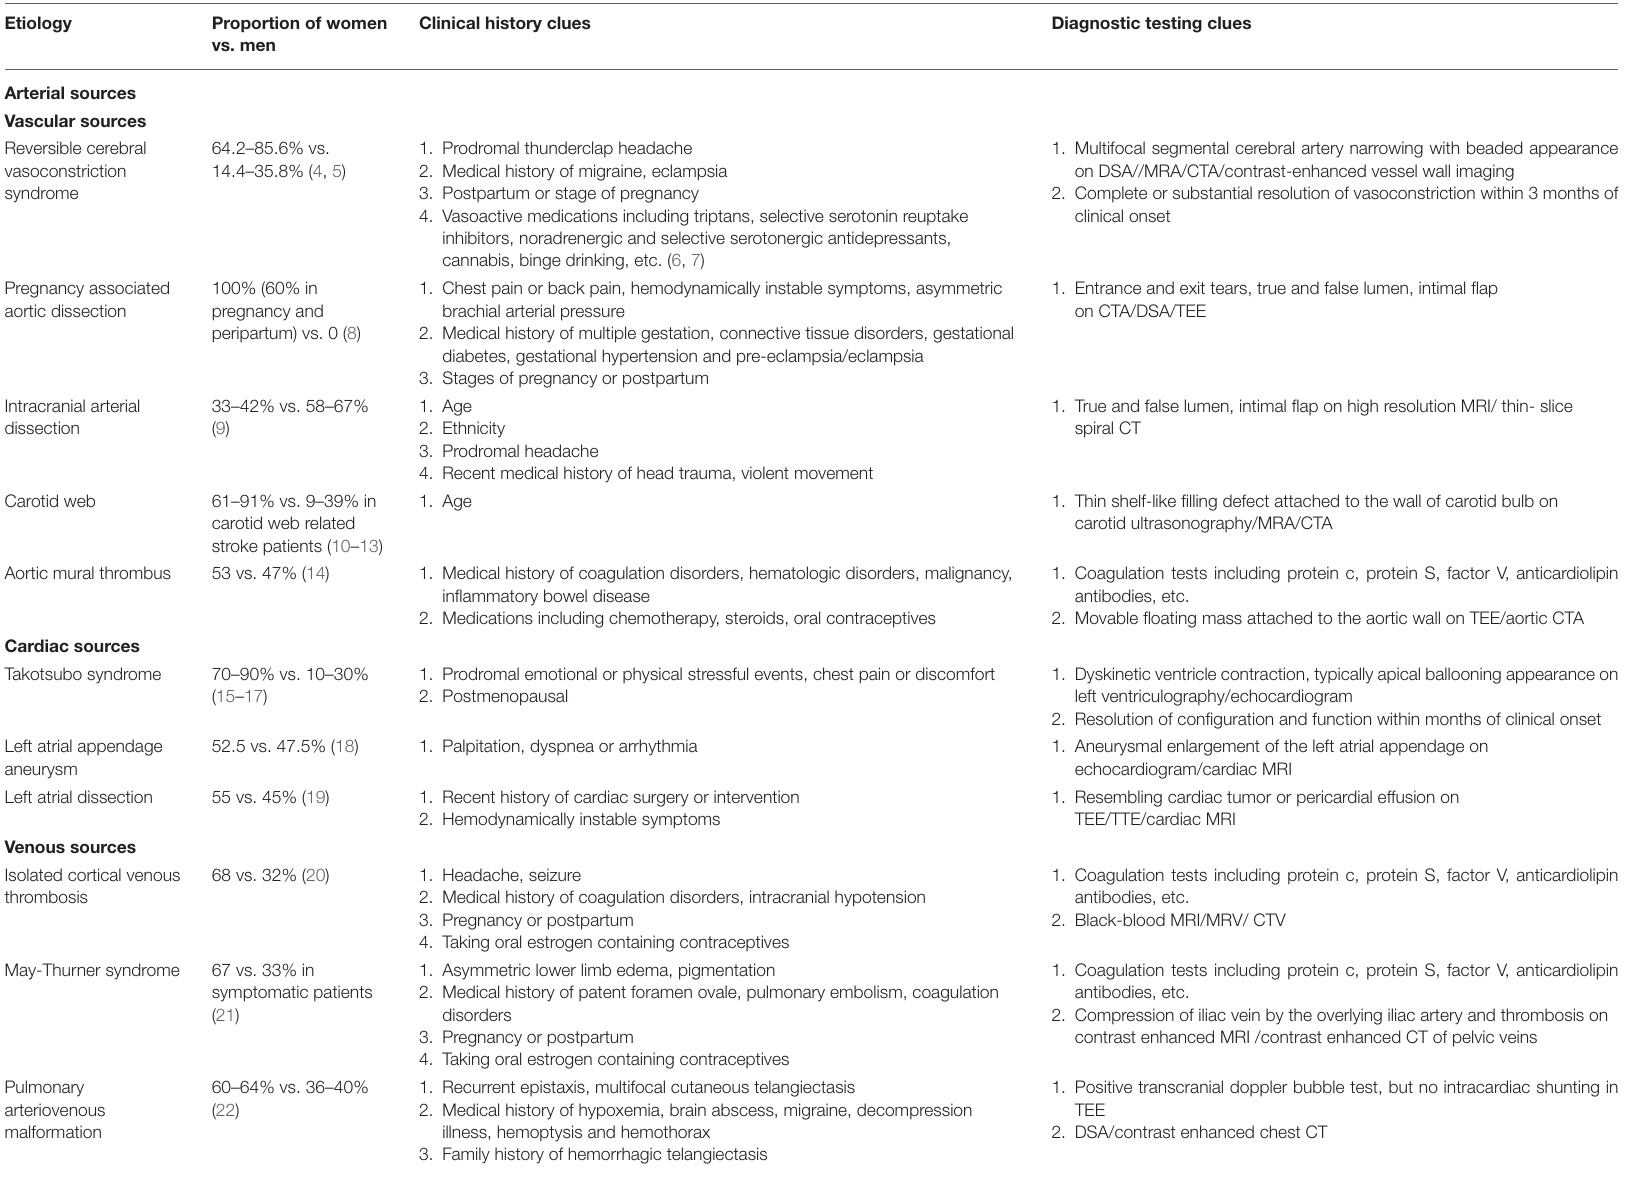
TABLE 1 | Proportion of women vs. men and screening recommendations for uncommon female-predominant etiologies of cryptogenic stroke. Etiology Proportion of women vs.